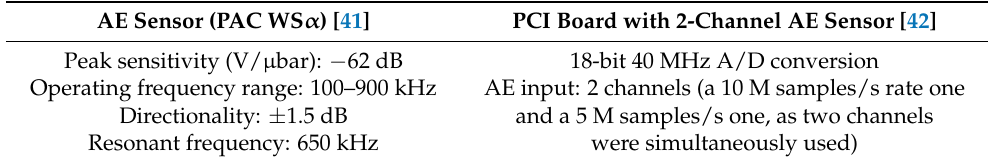
Table 2. Data acquisition system information